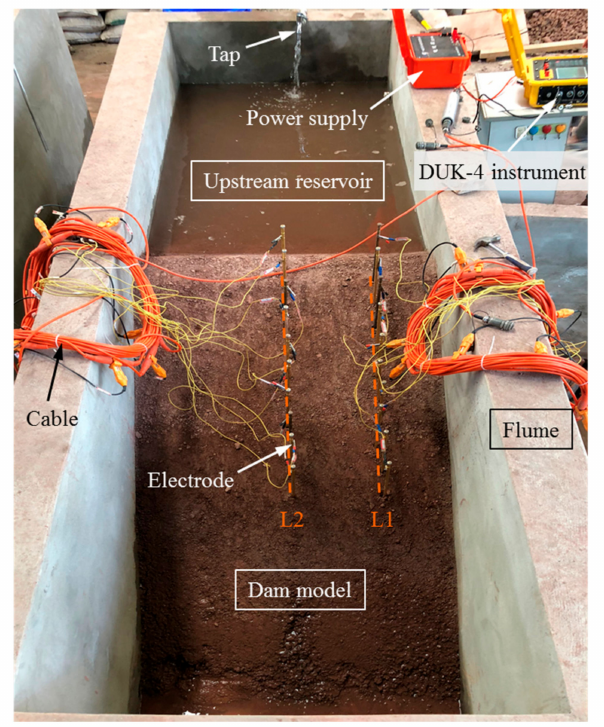
Figure 5. Photograph taken from the measurement on one of the dam models after the